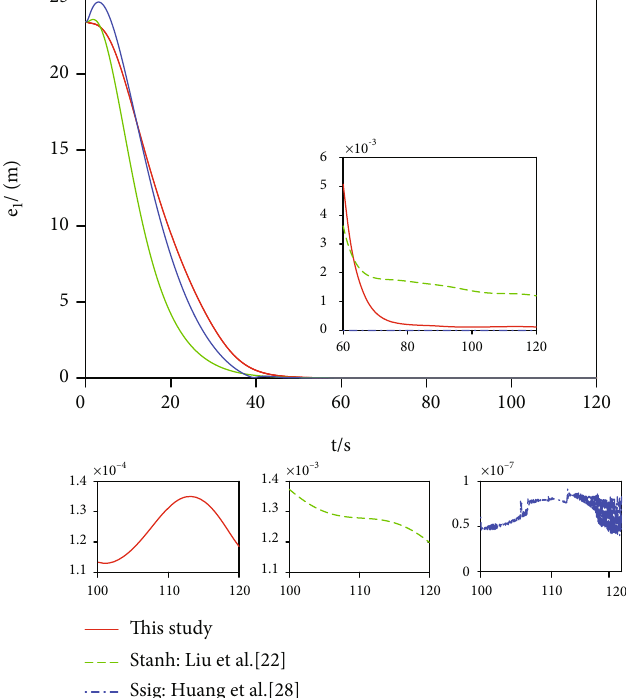
Figure 10: Relative distance error